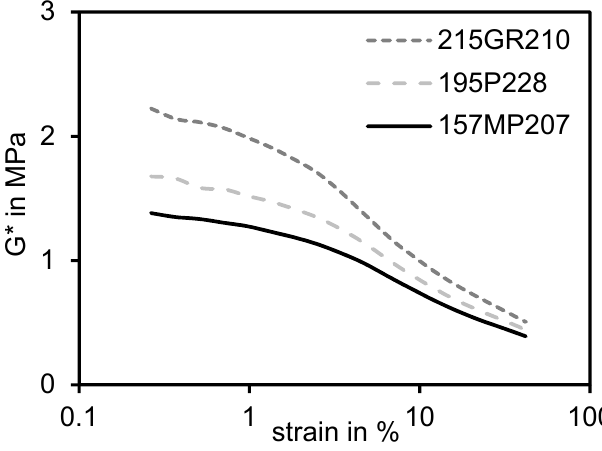
Figure 7. PAYNE-effect curves of three different types of silica without adding silane . Figure 7. PAYNE-e ff ect curves of three di ff erent types of silica without adding